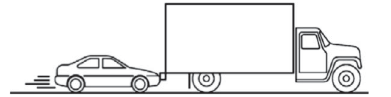
FIG. 1 (color online). Q.16 of the FCI